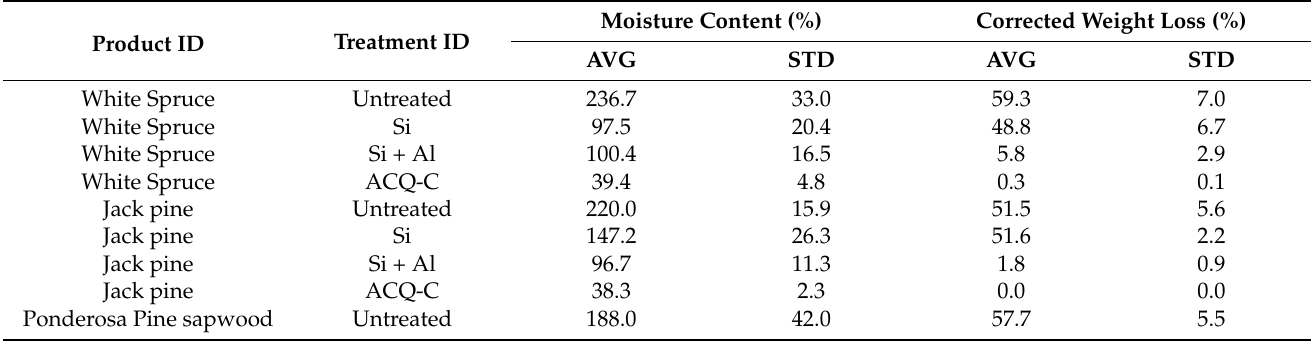
Table 7. Average values and standard deviations for moisture contents and corrected weight losses for test blocks exposed to Rhodonia placenta after 12 weeks of incubation.